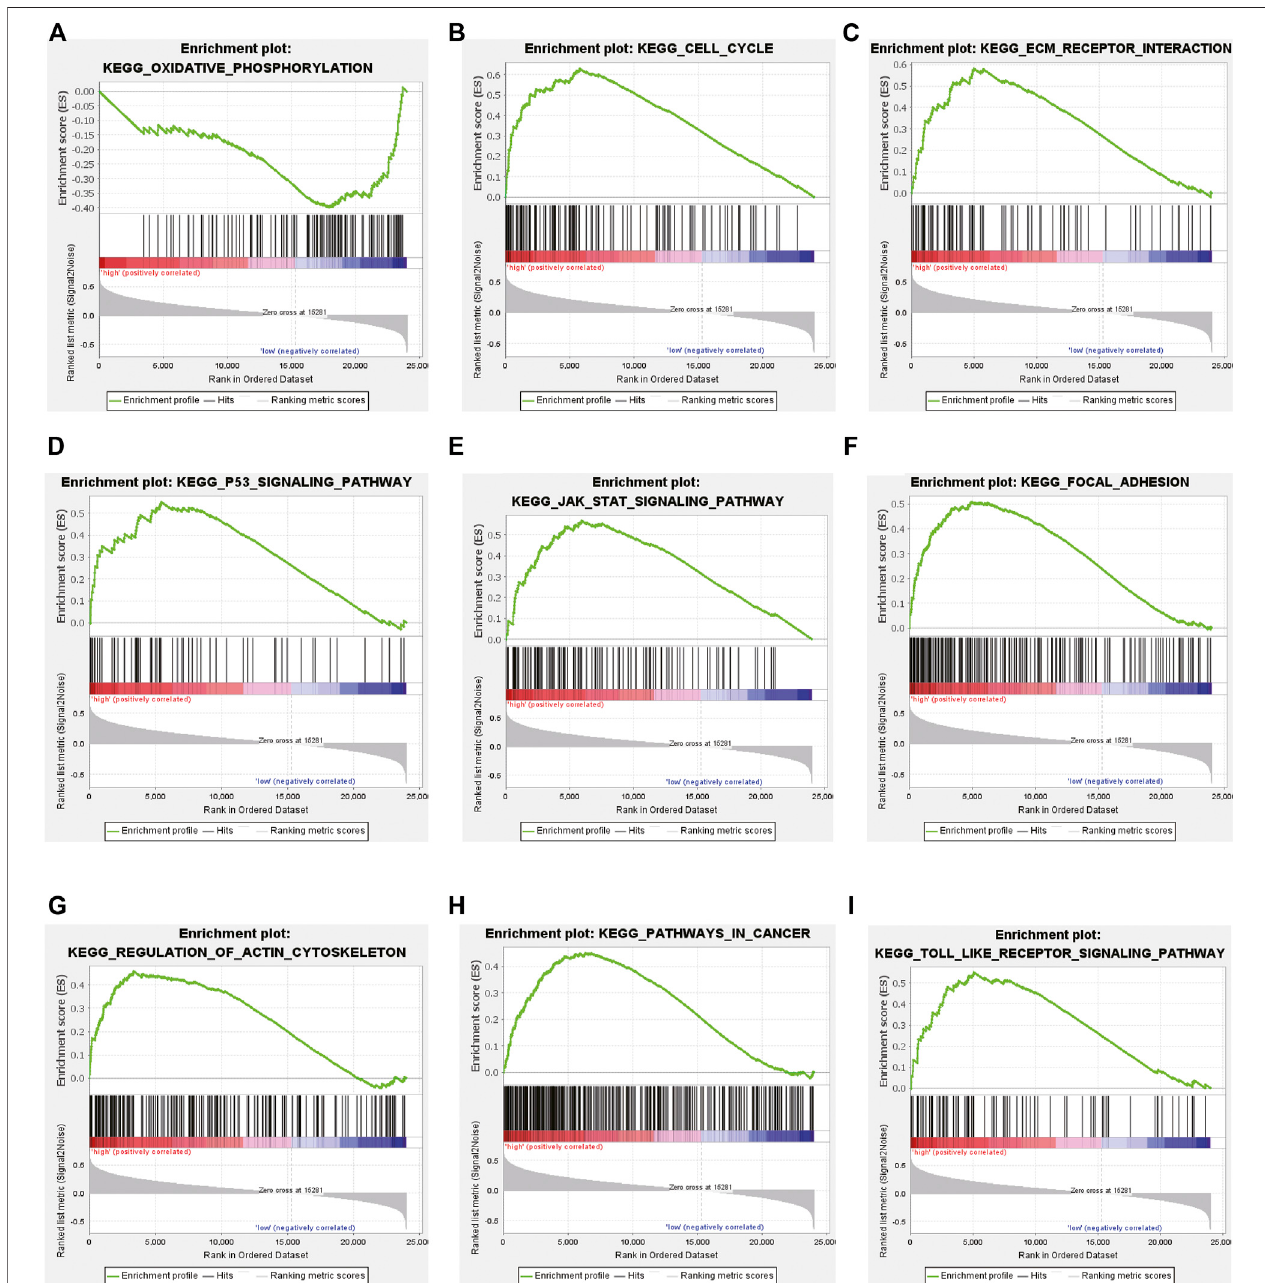
FIGURE6| Geneset enrichment analysis(GSEA)in thetrainingCGGA693 cohort. (A) GSEA suggested notableenrichmentofpathwaysinthelow-risk groupand (B – I) GSEA suggested signi fi cant enrichment in the high-risk group.